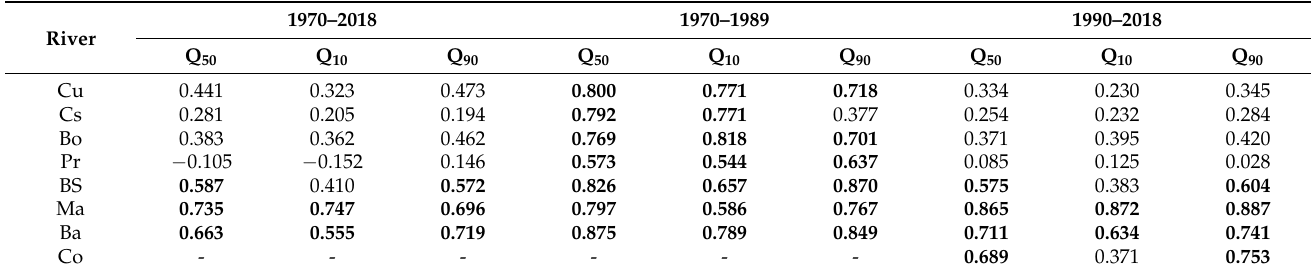
Table A3. KGE of the second-order MR models predicted by Niño 3.4 and DMI in SON a set in three different periods. The values higher than 0.5 are bolded, indicating good model skill.